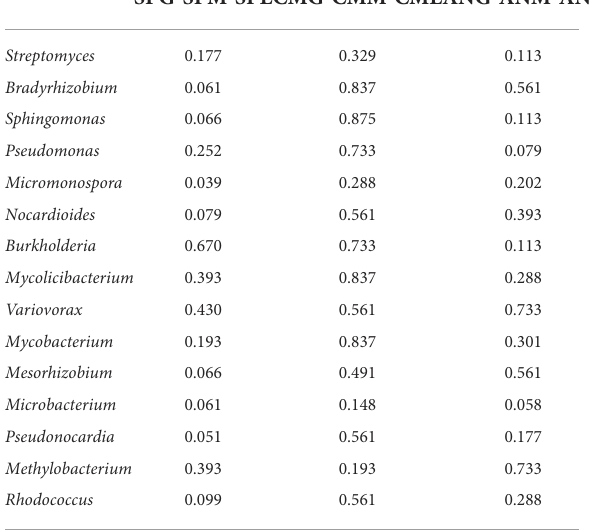
TABLE 2 Kruskal-Wallis test of the top 15 rhizosphere soil microorganisms under different grassland utilization patterns at genus level.